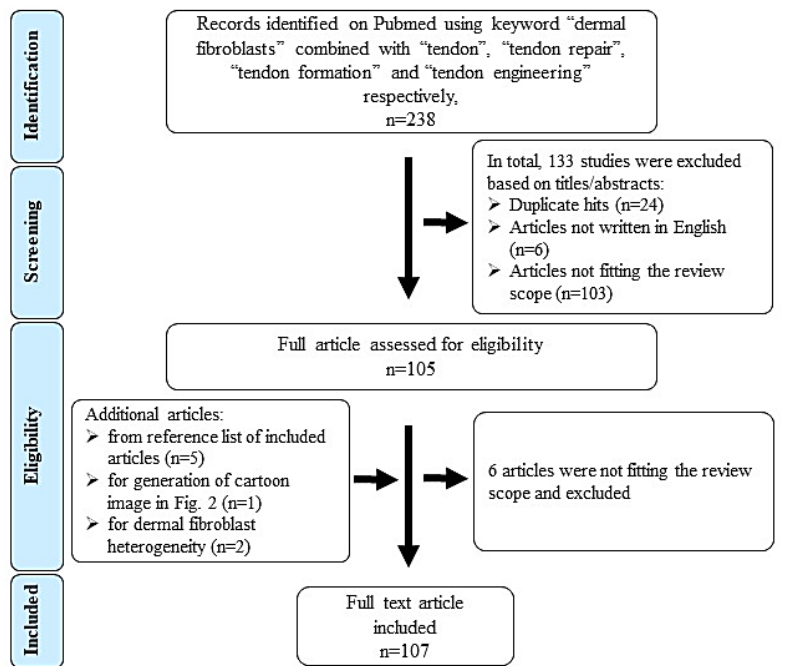
Figure 1. Flow chart representing the literature search and selection strategy (based on the PRISMA principle).